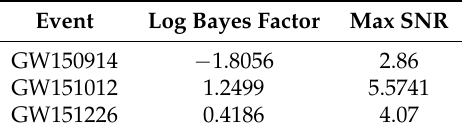
Table 12. Results of Bayes factor [24] using ADA model. Gaussian noise hypothesis is preferred for negative values of Log Bayes factor. Echoes hypothesis is preferred for positive values of Log Bayes factor. Log Bayes values of < 1 are “not worth more than a bare mention” [24]. However, we note that the Max SNR reported here by [24] for GW150914 is inconsistent with the one reported by the same group and ADA previously [18,23] (see Table